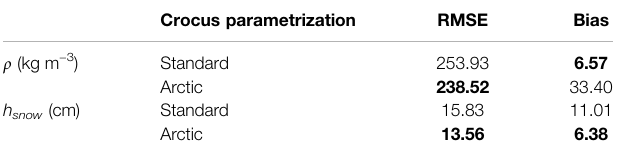
TABLE 4 | Root mean square error (RMSE) and mean bias for the four detailed validation sites above the tree line, for bulk snow density ( ρ ) and snow depth ( h snow ). Best results are highlighted in